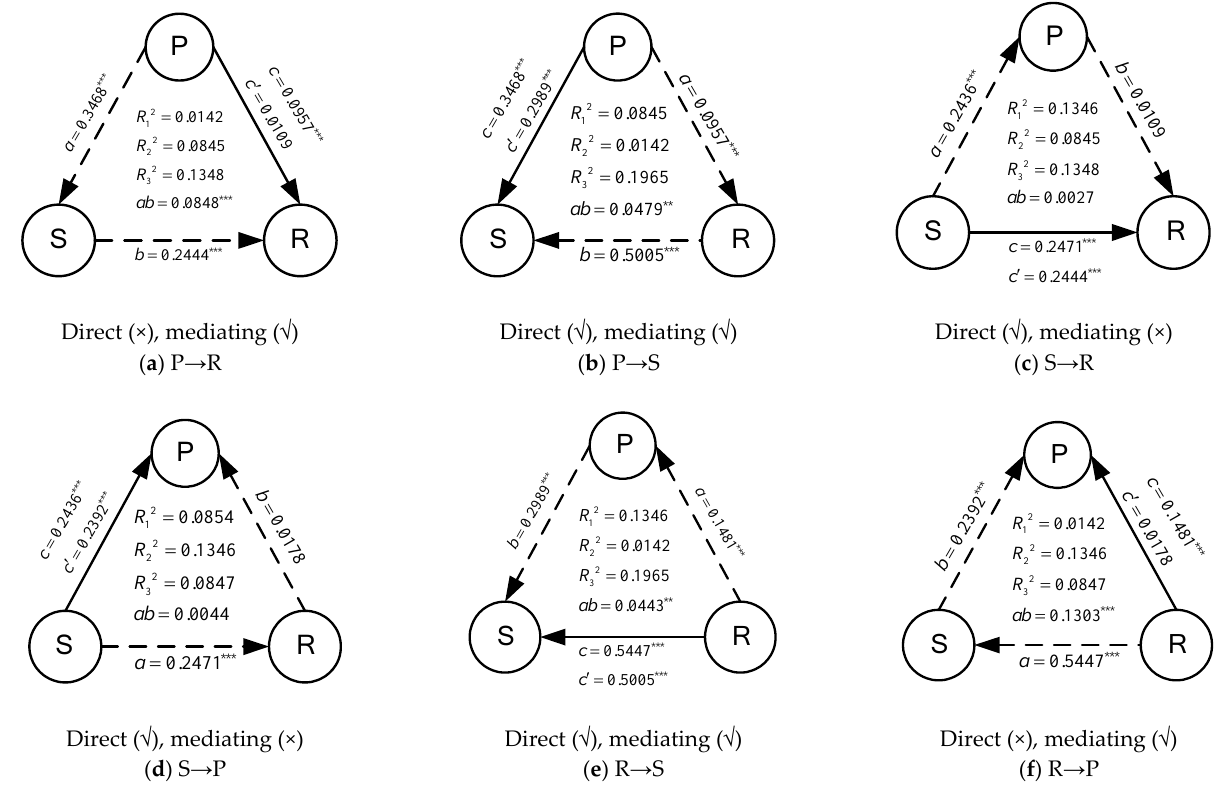
Figure 5. The transmission path of pressure–state–response.